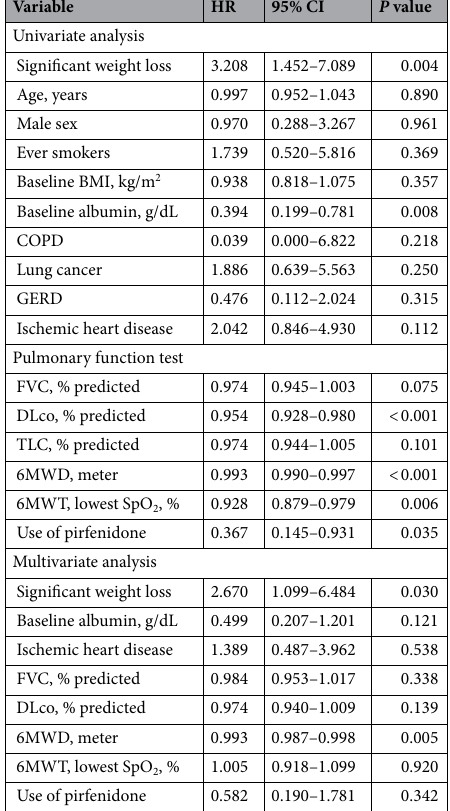
Table 4. Cox regression analysis of risk factors for mortality. Among the significant variables in the univariate analysis, TLC (r = 0.974, p = 0.101) was excluded in the multivariate analysis due to close correlation with FVC.